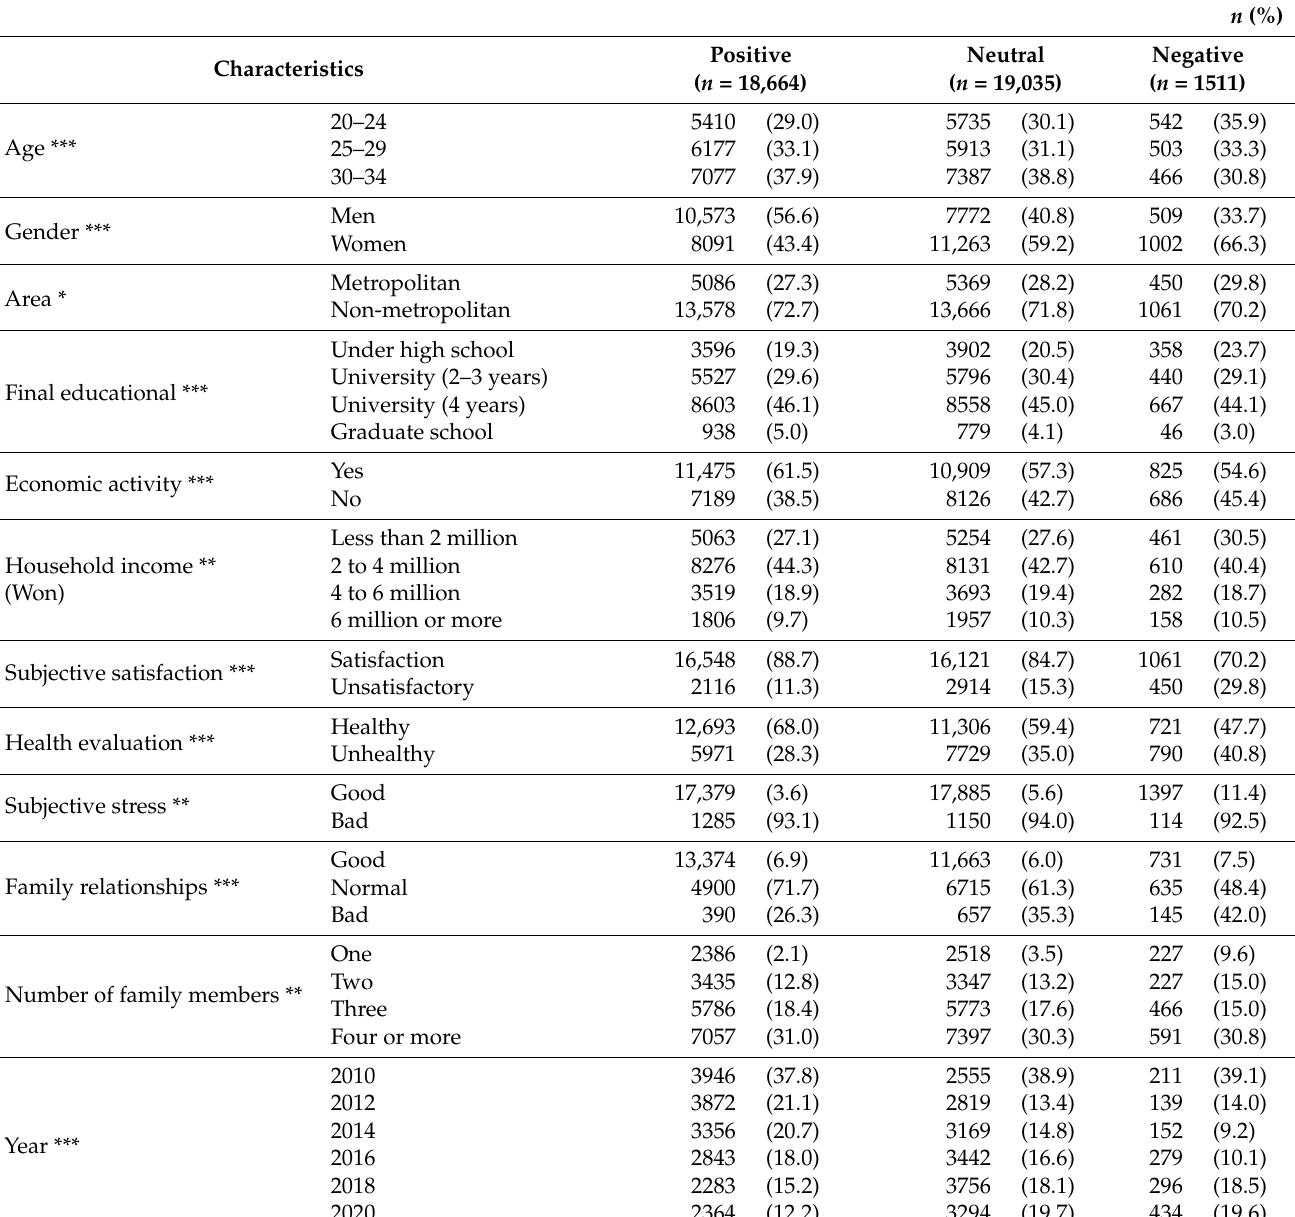
Table 1. Marriage intentions and demographic characteristics of unmarried youth aged 20–34